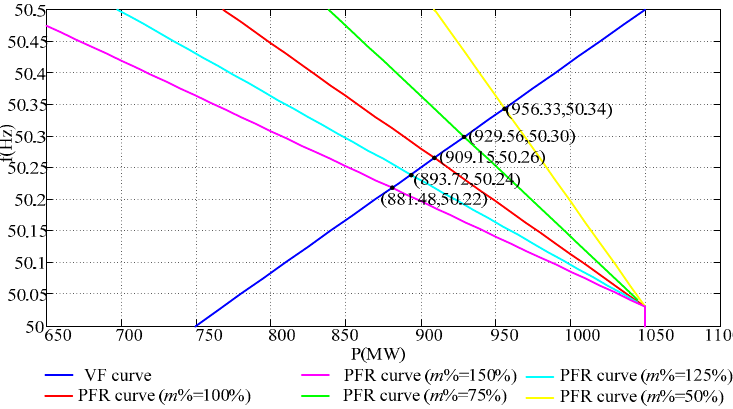
Figure 11. VF curve and PFR curves ( Δ PB = +300 MW).